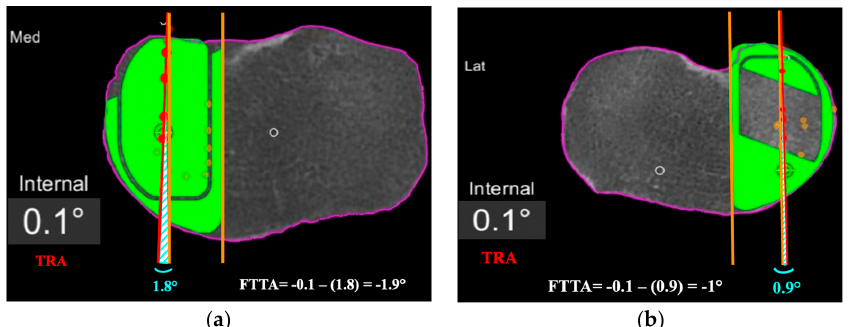
Figure 4. Femoro-tibial tracking angle is calculated by subtracting the angle between a line tangent to the lateral border of the tibial component and a line passing across at least 4 consecutive femoro- tibial tracking points (light blue angle) with the tibial tracking angle (TRA). FTTA is –1.9° in ( a ), and –1° in ( b